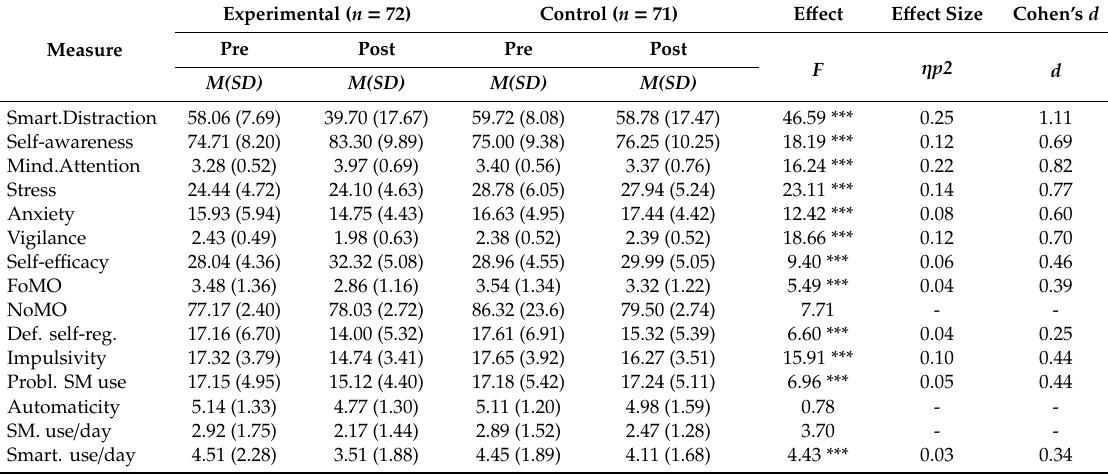
Table 4. Per protocol sample ( n = 143) primary and secondary measures, means, SDs, e ff ect sizes and F -values for between-group